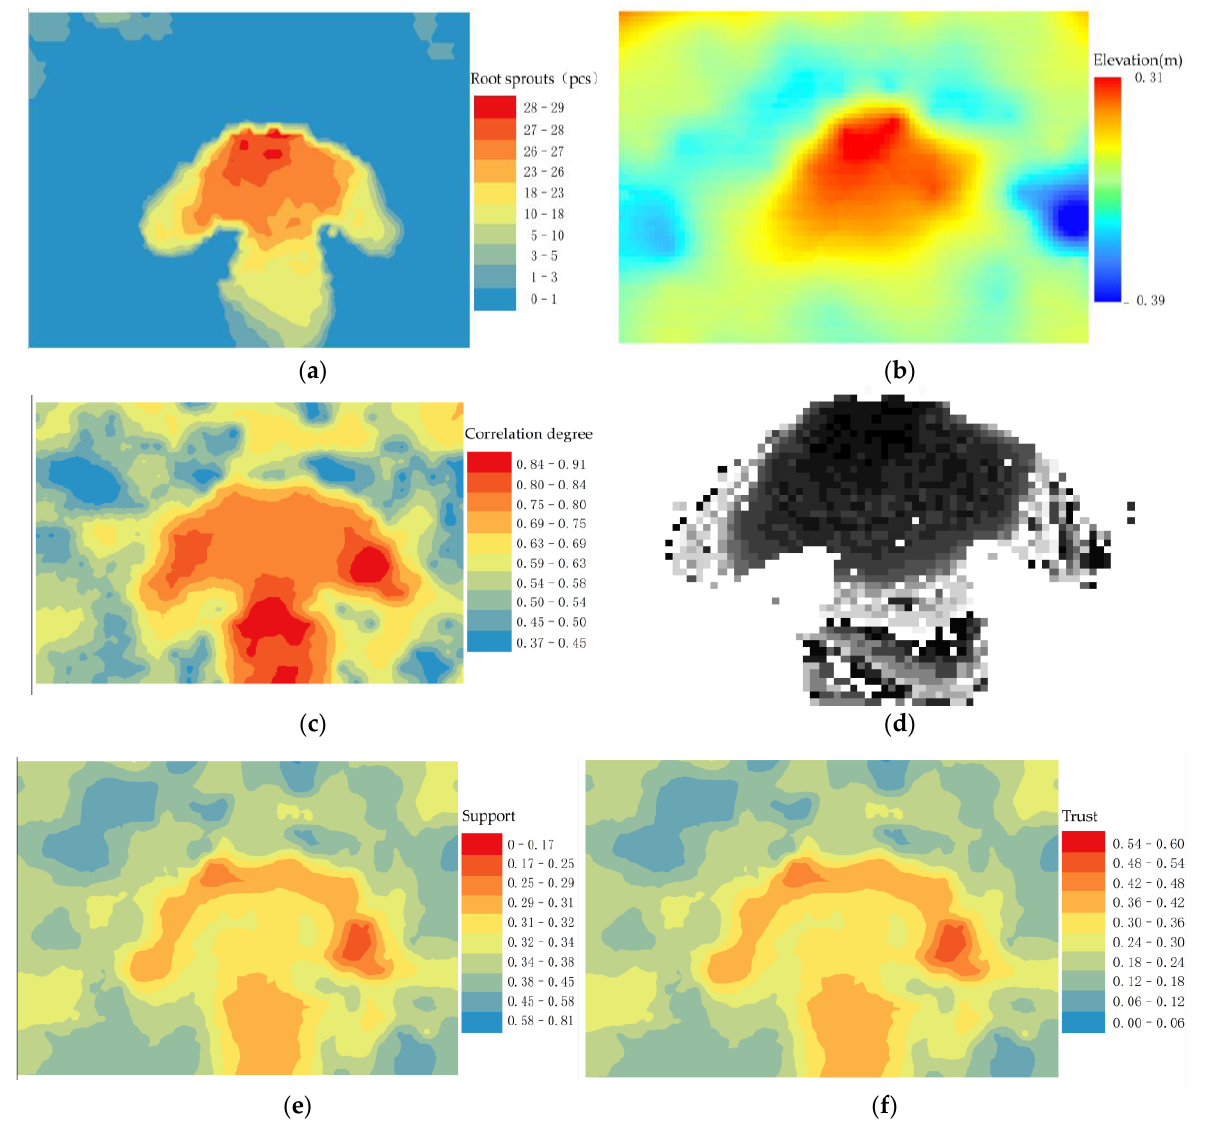
Figure 6. Root sprout distribution, elevation and algorithm run processing results in the study area. ( a ) Distribution of root sprouts in the study area; ( b ) Elevation of the study area; ( c ) Event intensity distribution; ( d ) Positive case event distribution; ( e ) Spatial support; ( f ) Spatial trust.